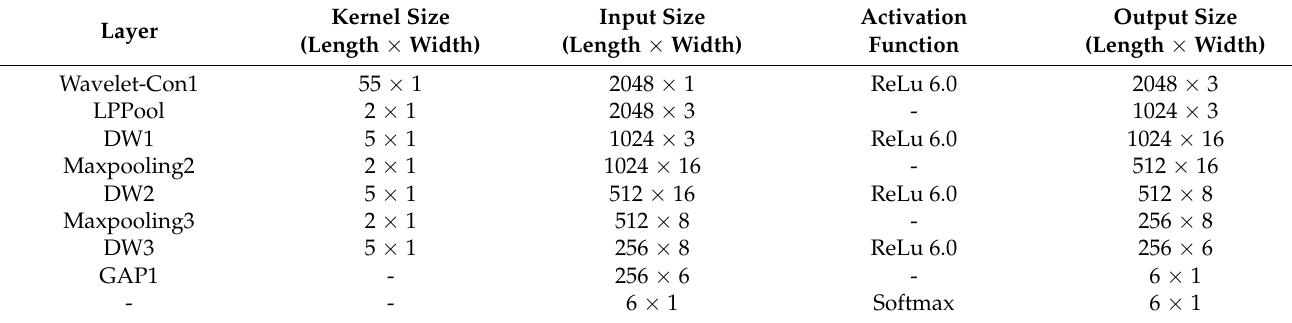
Figure 6. Data enhancement diagram. If the total length of data in a certain state is 𝐿 , the data length of each sample is 𝑙 . Using the mobile window overlap sampling enhancement method, the data are sampled with the offset 𝛼 , and the data length of the overlapped part is l- α . The number of samples